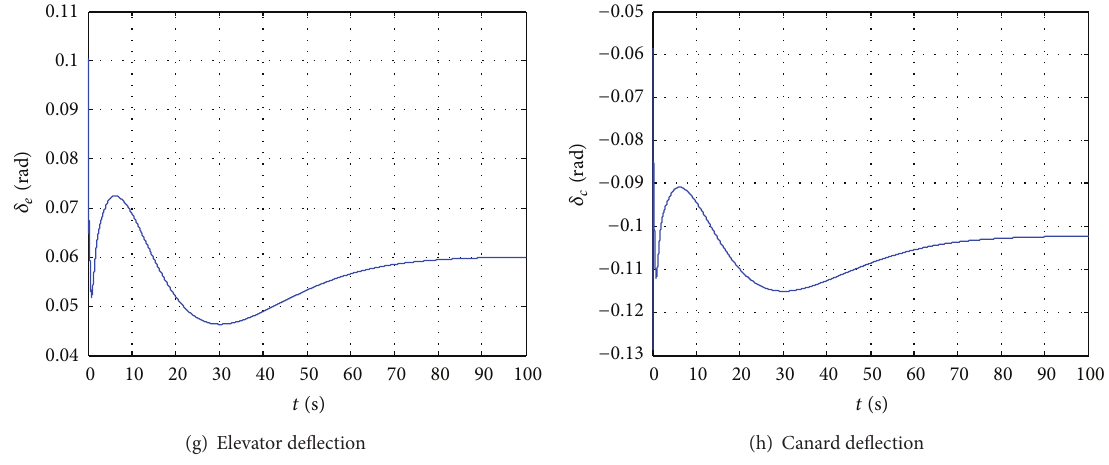
Figure 2: Climbing maneuver with longitudinal acceleration for case